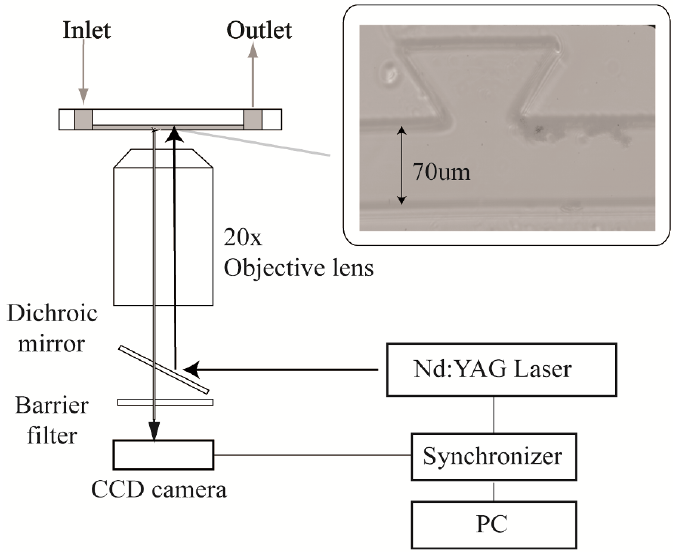
Figure 2. Micro particle-image velocimetry experimental setup. Inset shows trapezoidal side